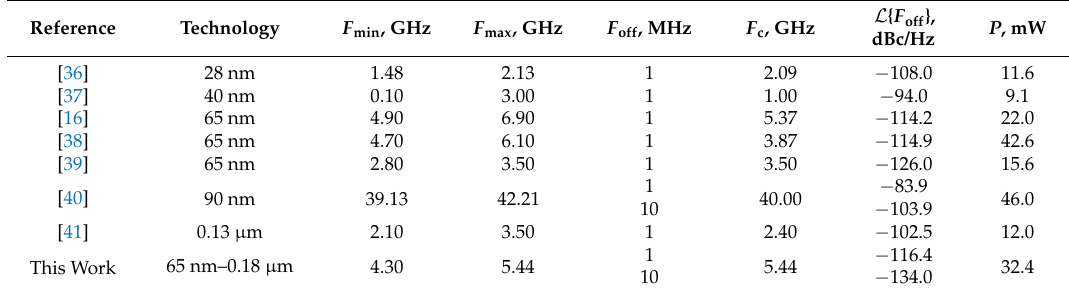
Table 2. Comparison of calculated parameters of frequency synthesisers to other